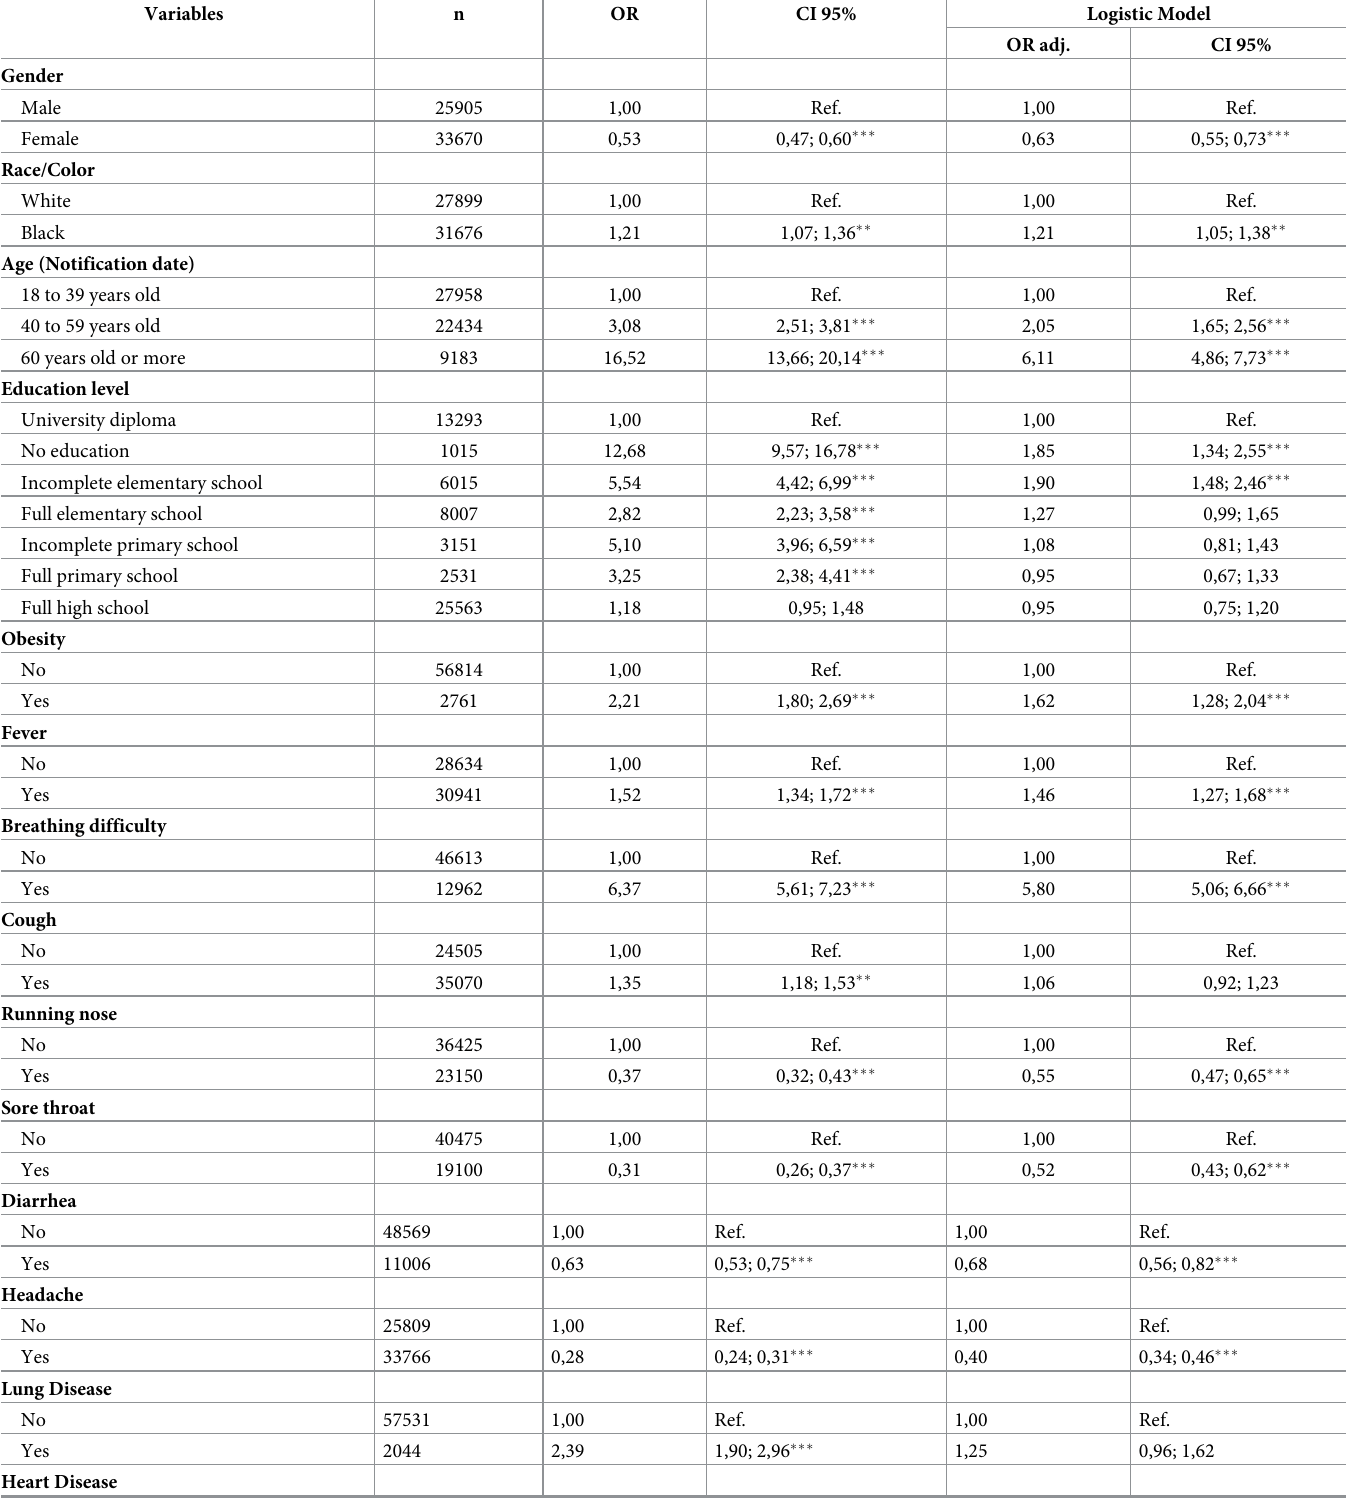
Table 3. Logistic regression model for the association of sociodemographic factors and symptoms with hospitalization for COVID-19, Espı´rito Santo, Brazil,